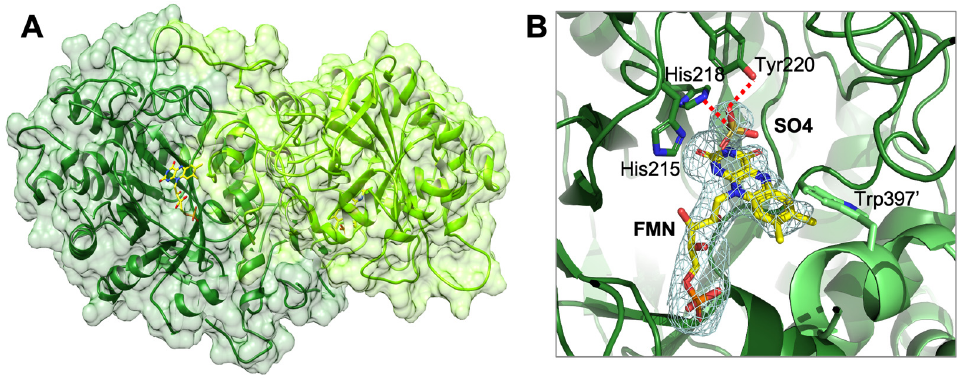
Figure 3. Cartoon representation of the crystal structure of An OYE8 (PDB: 7QFX): ( A ) surface representation showing the two protein chains forming the dimeric architecture; ( B ) details of An OYE8 active site, where the ligands omit map (FMN and SO 4 ) was calculated by Phenix and is shown contoured at 2.5 σ . The two protomers of An OYE8 are colored in forest green and light green. FMN cofactor and sulphate anion (SO 4 ) bound in the active site are shown with C atoms in yellow and orange, respectively. Most relevant residues of the catalytic cavity are shown with forest green C atoms, while Trp397 ′ of the adjacent protomer is shown with light green C atoms, red for O, and blue for N. Hydrogen bonds are shown as red dashed lines.